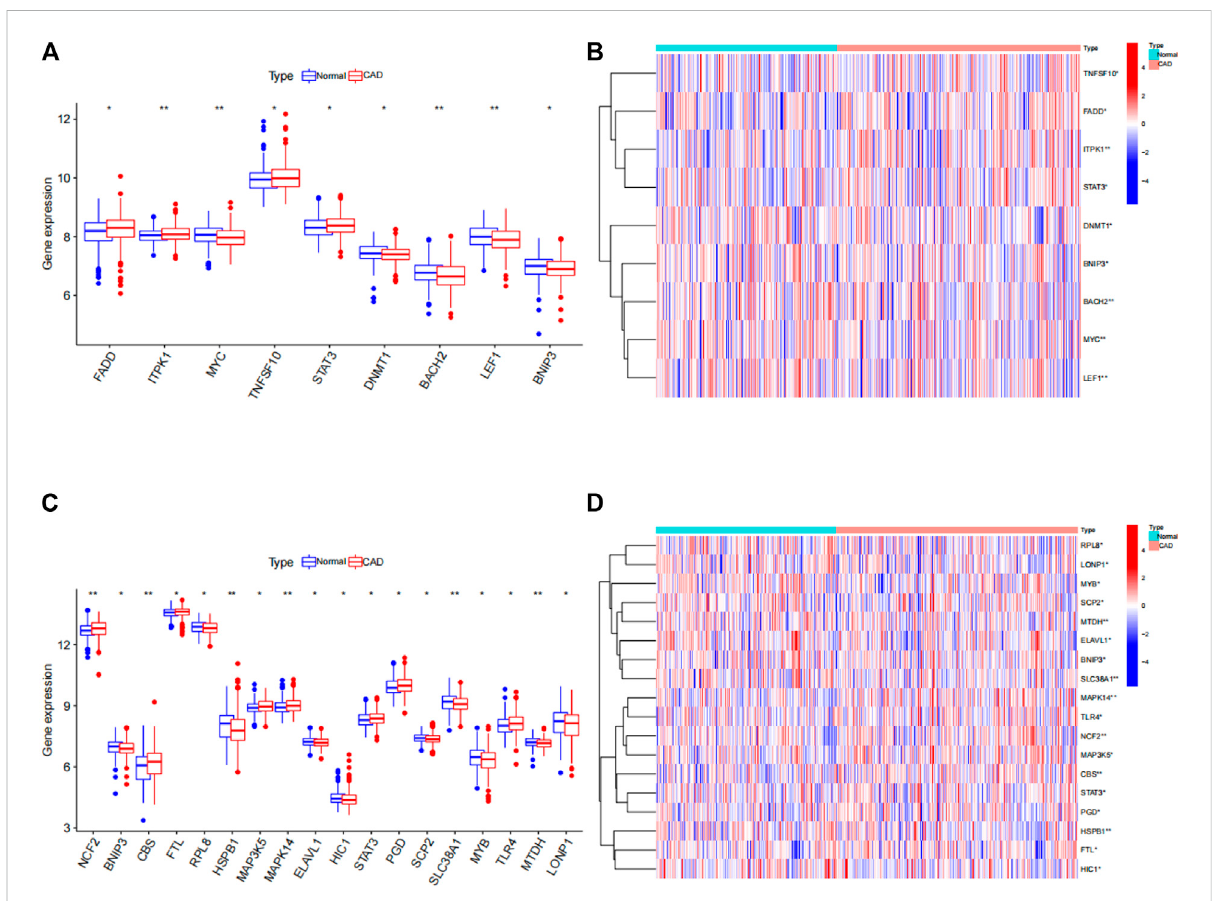
FIGURE 3 Differences in the expression of 25 ferroptosis- and necroptosis-related genes in control (con) and CAD (treat) groups. (A) Differential expression histogram of the nine necroptosis-related genes identi fi ed between controls and patients with CAD. (B) Expression heat map of the nine necroptosis-related genes in controls and patients with CAD. (C) Differential expression histogram of the 18 ferroptosis-related genes identi fi ed between controls and patients with CAD. (D) Expression heatmap of the 18 ferroptosis-related genes in controls and patients with CAD. * p < 0.05, ** p < 0.01, and *** p <